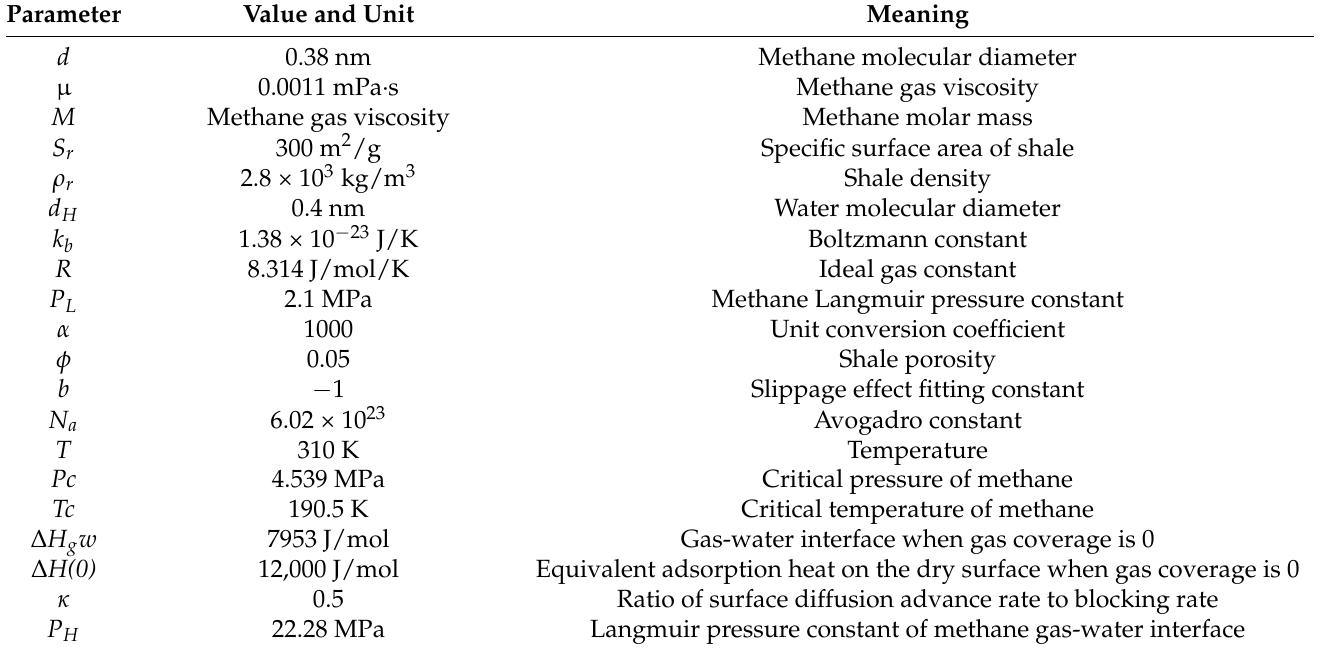
Table 1. List of basic